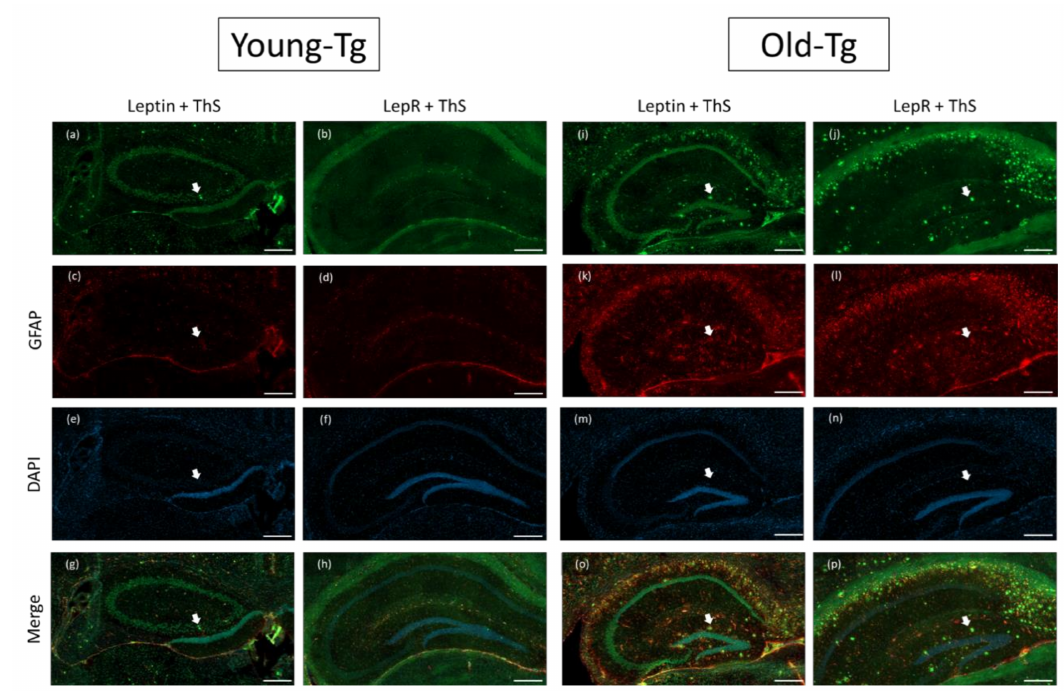
Figure 3. Leptin and LepR with Thioflavin-S and glial fibrillary acidic protein (GFAP) staining on the hippocampi of young (10–12 week) and old (48–52 week) 5XFAD (Tg) mice. Amyloid plaques